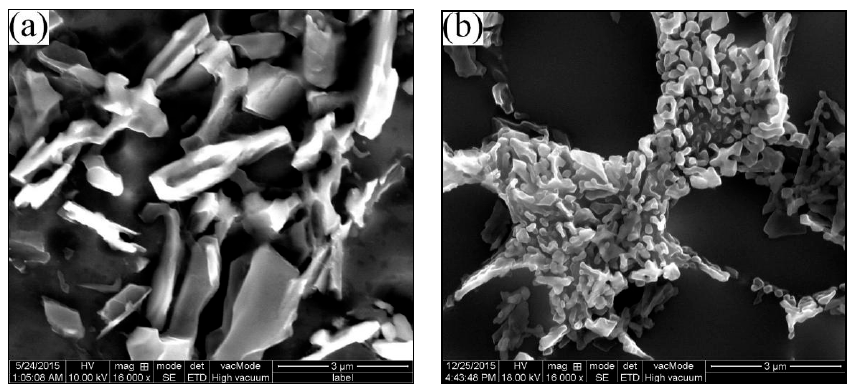
Figure 8. The morphology of the eutectic phase ( a ) High Pressure Die Casting (HPDC); ( b ) Figure Rheo-Diecasting (RDC).